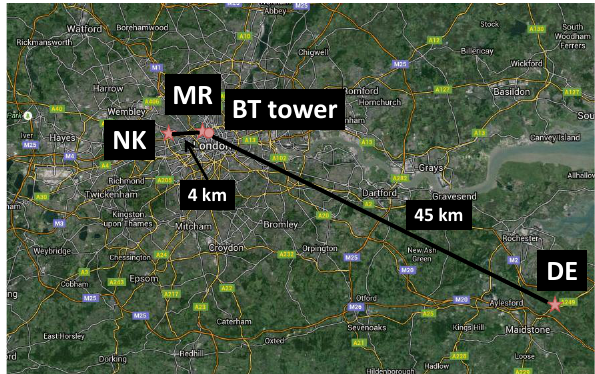
Figure 1. Map of southeastern UK. Indicated are the sampling sites MR (kerbside site Marylebone Road), NK (urban background site North Kensington), DE (rural site Detling), and the elevated BT Tower site for meteorological measurements (adapted from Google